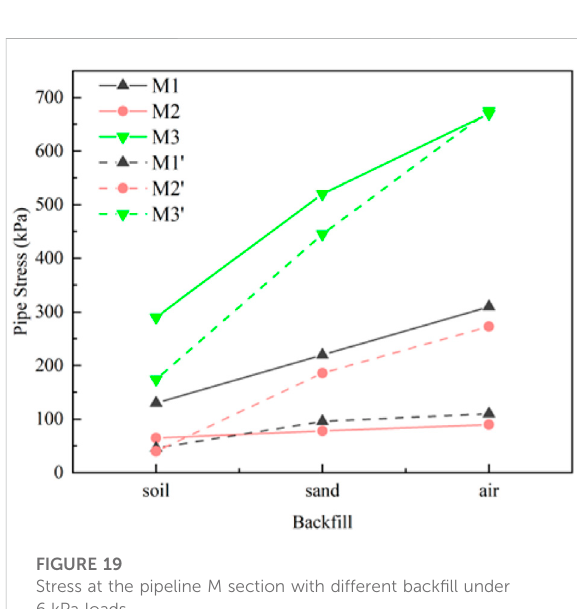
FIGURE 19 Stress at the pipeline M section with different back fi ll under 6 kPa loads.